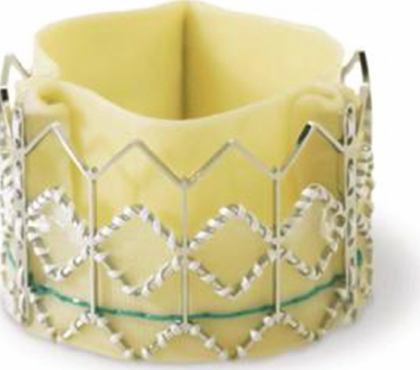
Figure 1: The Edwards-Sapien balloon-expandable prosthetic valve, constructed of a stainless-steel stent, bovine pericardial leaflets and a fabric sealing cu ff .